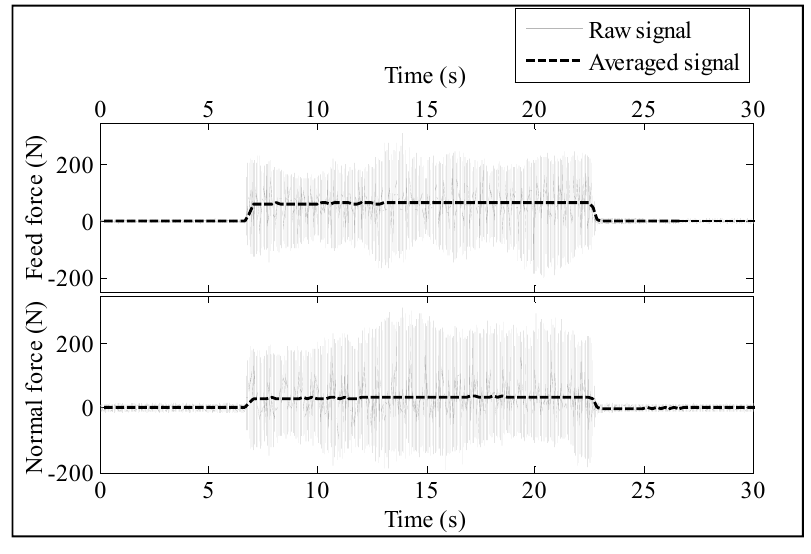
Figure 7. Forces signals.